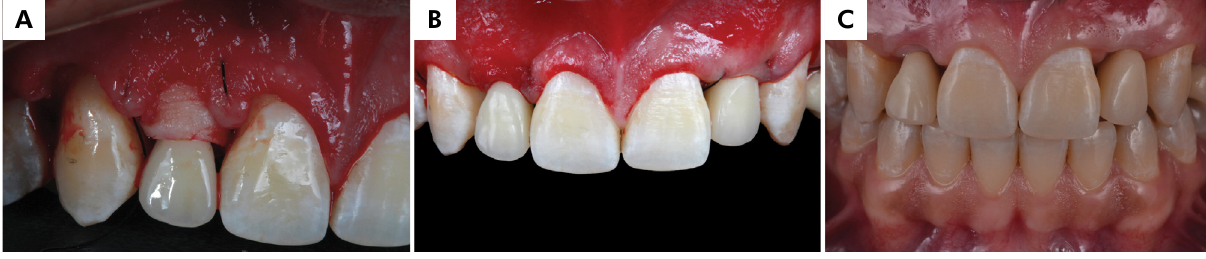
Figure 5. The CTGs were sutured at the implants’ facial aspect (a), and the flap was coronally positioned (b). Three months after healing, the ridge volume and soft tissue margins were improved, but the papillae were still missing (c).